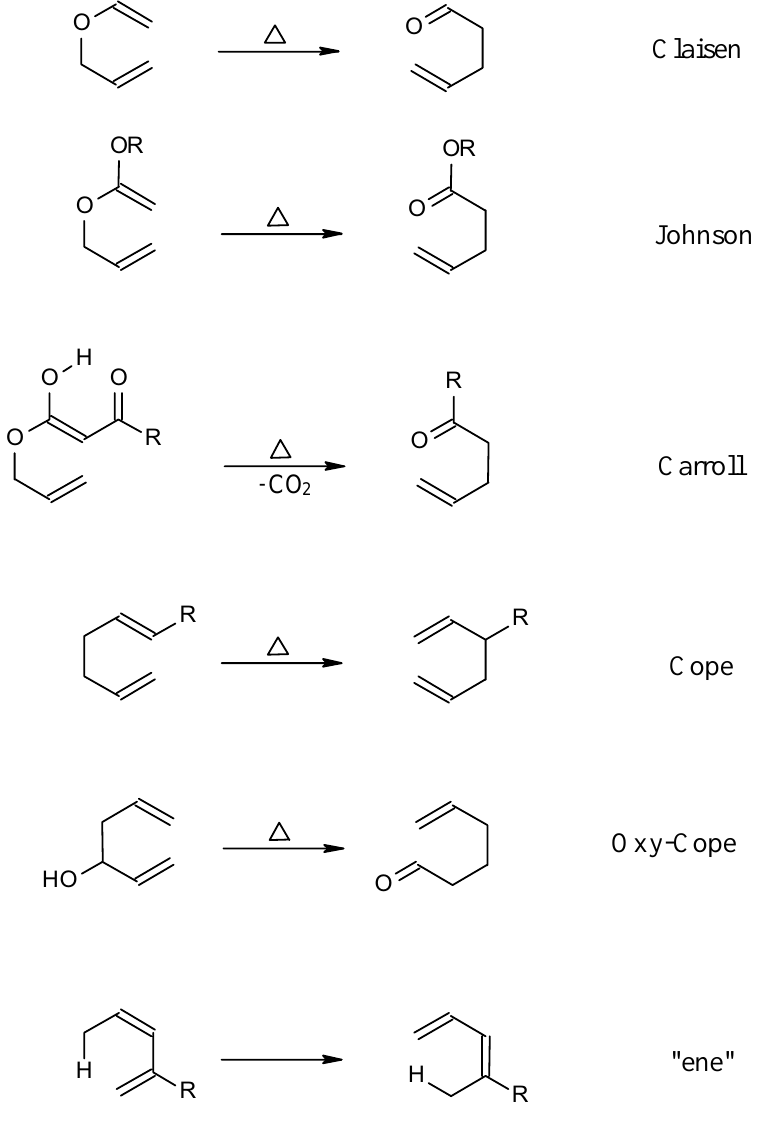
Scheme 3. Types of [3,3]-sigmatropic